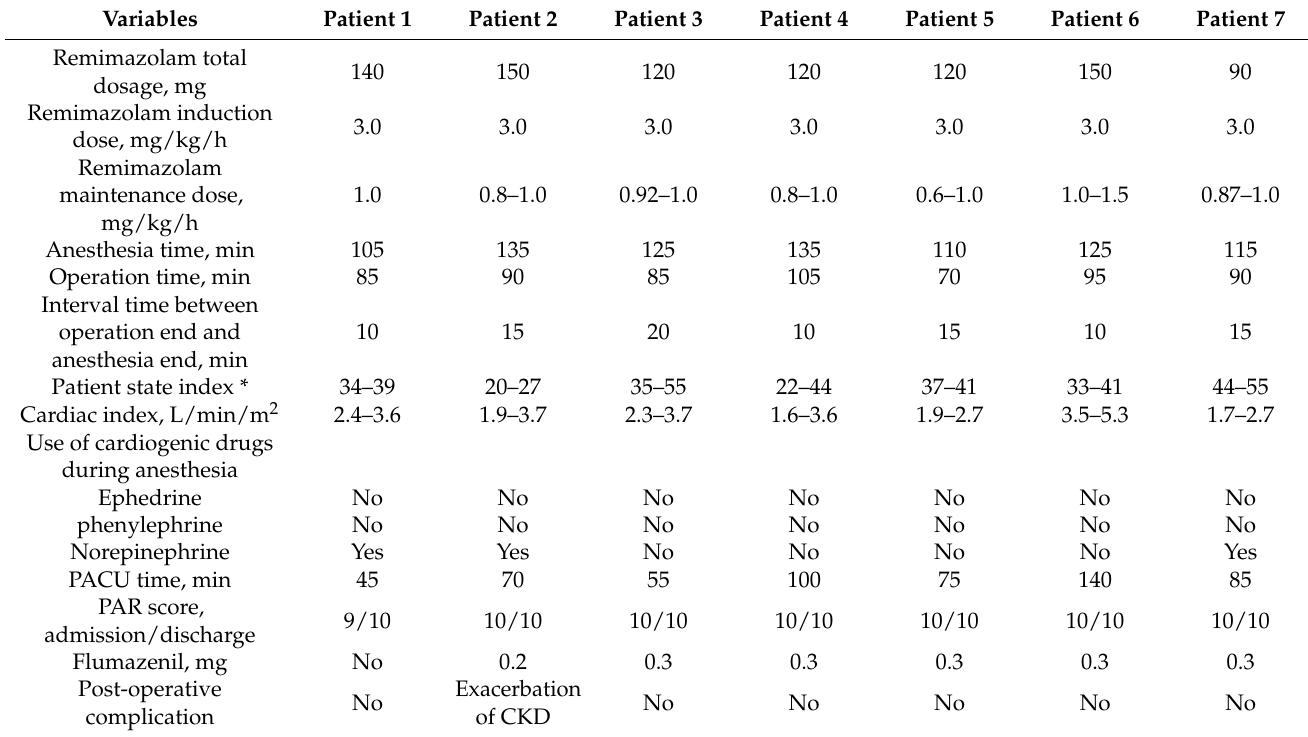
Table 3. Perioperative data of